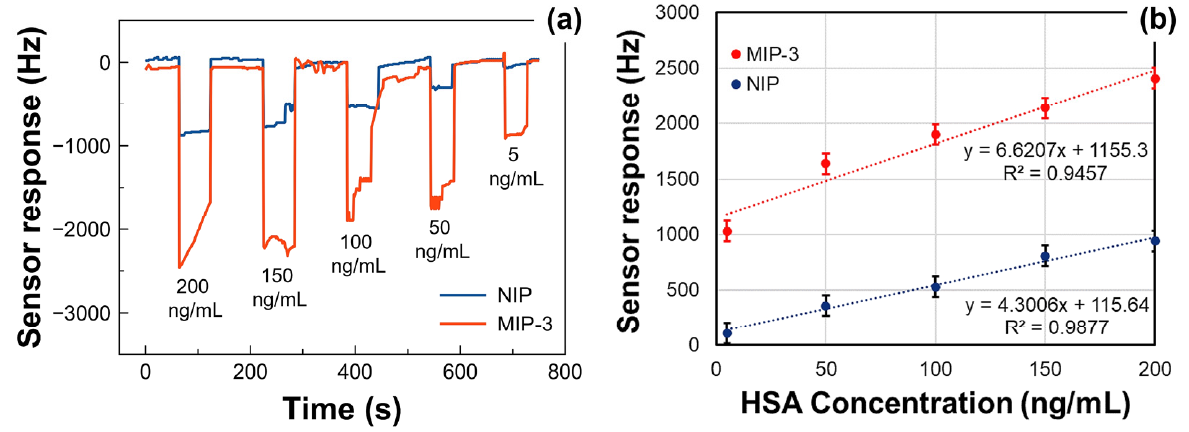
Figure 6. ( a ) Sensor response of Ag-ZnS@MIP and Ag-ZnS@NIP coated QCM devices toward different concentrations of HSA. ( b ) The linear detection range and sensitivity of Ag-ZnS@MIP and Ag-ZnS@NIP-based HSA sensors are depicted by the respective calibration curves. On further testing of the lower concentrations of HSA, the sensor shifts by the Ag- ZnS@MIP layer remain significantly higher than Ag-ZnS@NIP. The lowest tested concen- tration was 5 ng/mL of HSA where the response of the Ag-ZnS@MIP layer was 1030 Hz